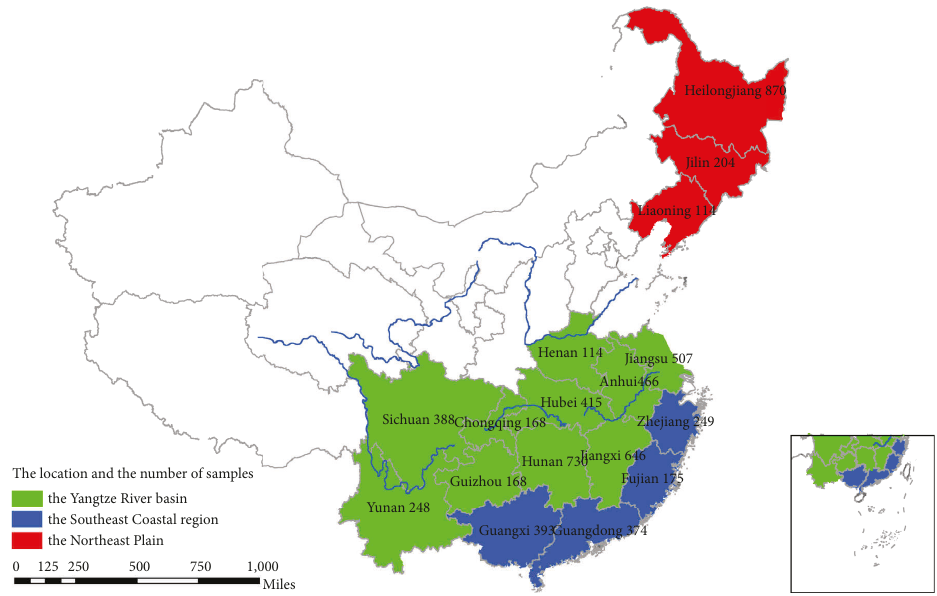
Figure 1: The location and the number of samples from three main rice-producing regions in China ( n � 6229).